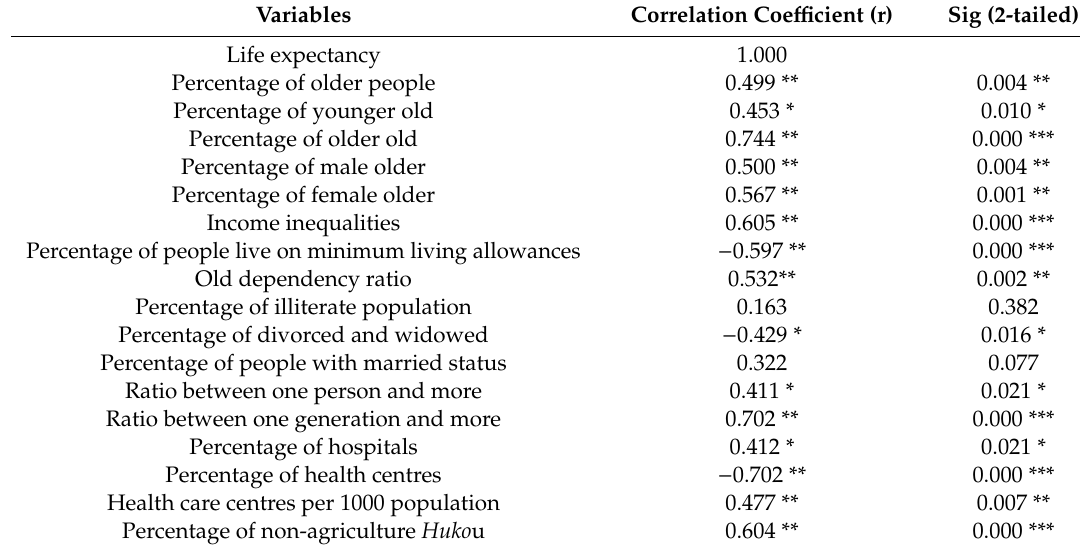
Table 4. Correlation of variables.